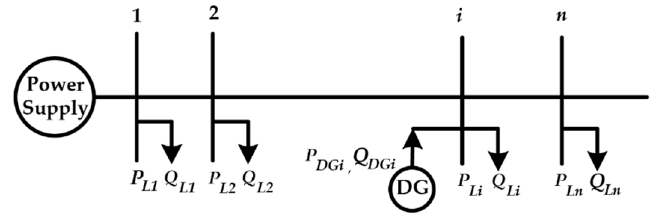
Figure 1. Multi ‐ load single radiating line with